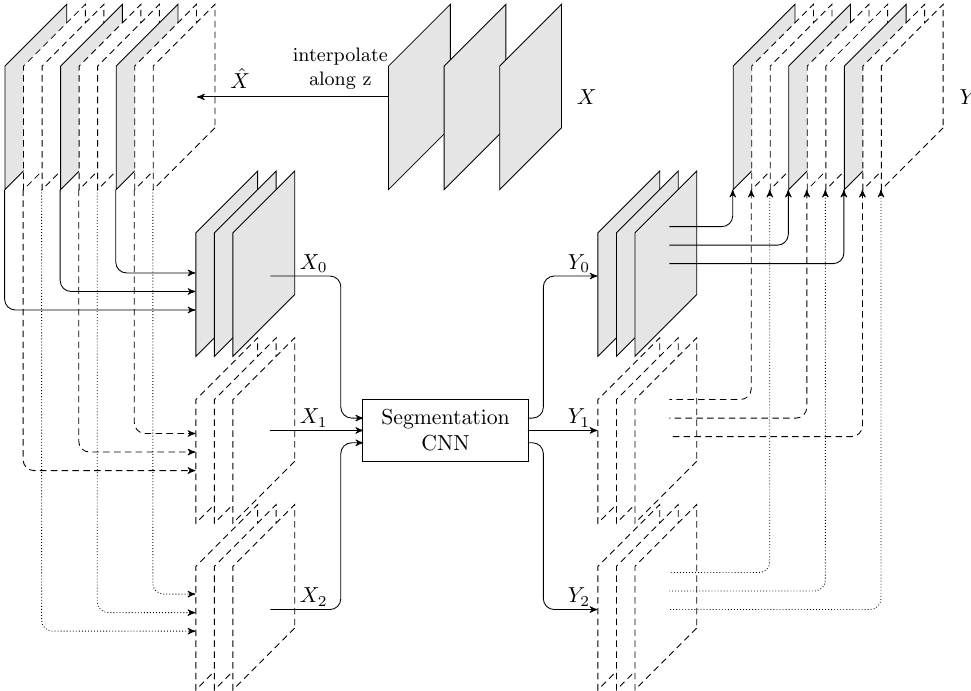
Figure 4. Visual representation of the Neural Resolution Enhancement method to triplicate the resolution along the